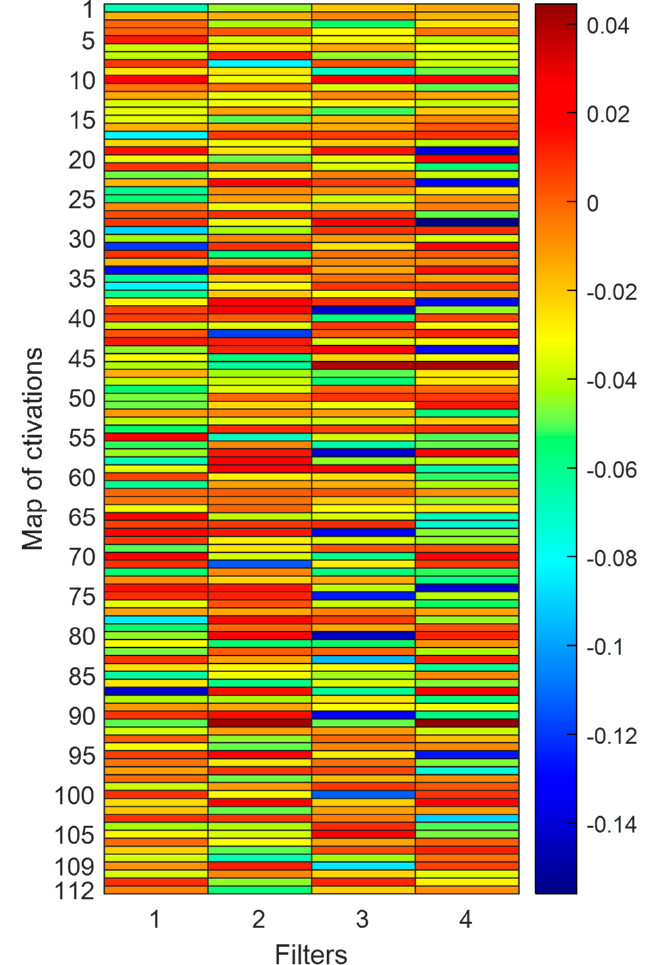
Figure 12. Activations of CNN 1D convolutional layer. Layer (#4) is a dropout layer that randomly sets input elements to zero with a probability of 30%. This operation changes the basic network architecture to prevent overfitting of the neural network. The percentage value of the coefficient is adjusted experimentally.